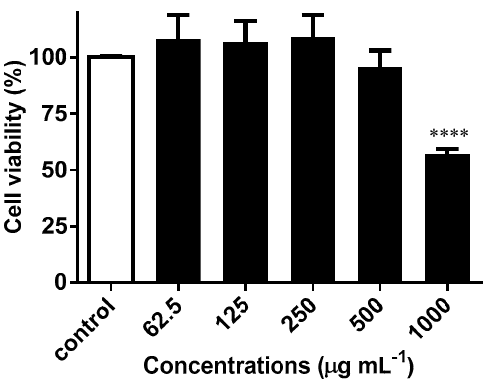
Figure 5. Effects of H. bhamoense trunk bark extract on HaCaT cell viability. Results correspond to the mean ± SEM of three independent experiments performed in triplicate (statistical significance: **** p < 0.0001).